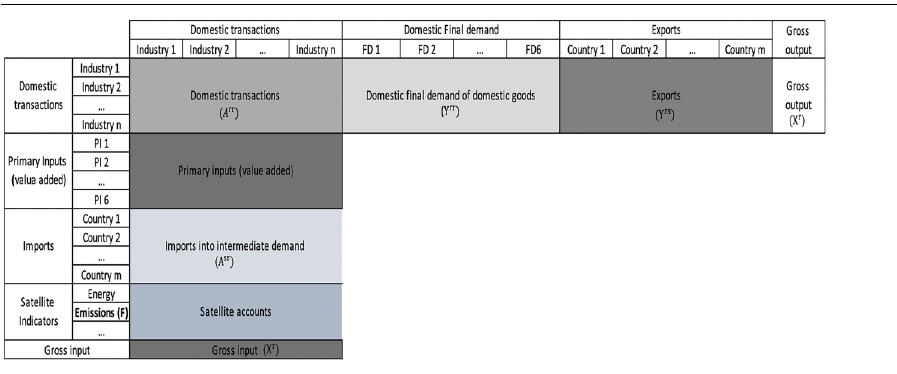
Table 1 Format of input–output table in the EEBT